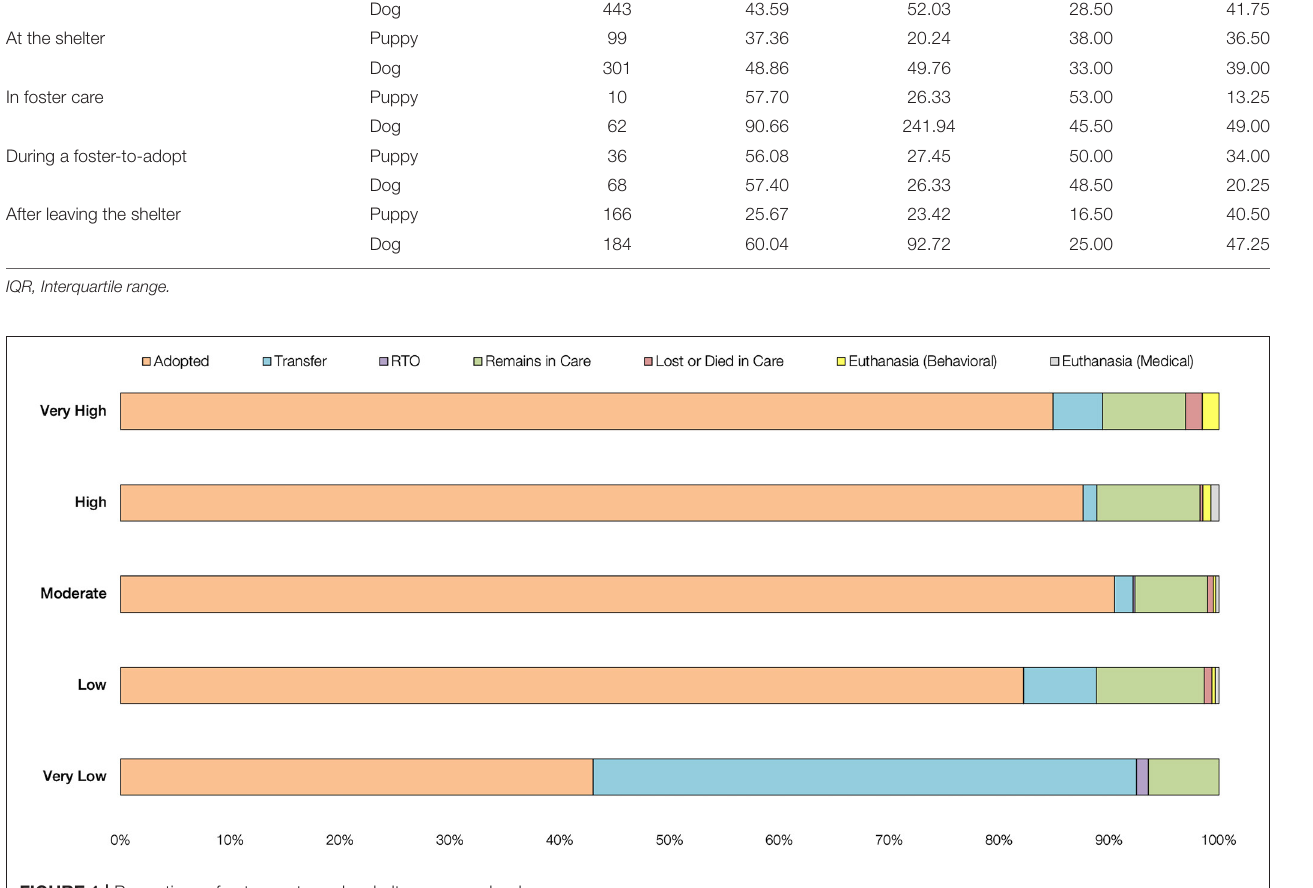
FIGURE 1 | Proportions of outcome types by shelter resource